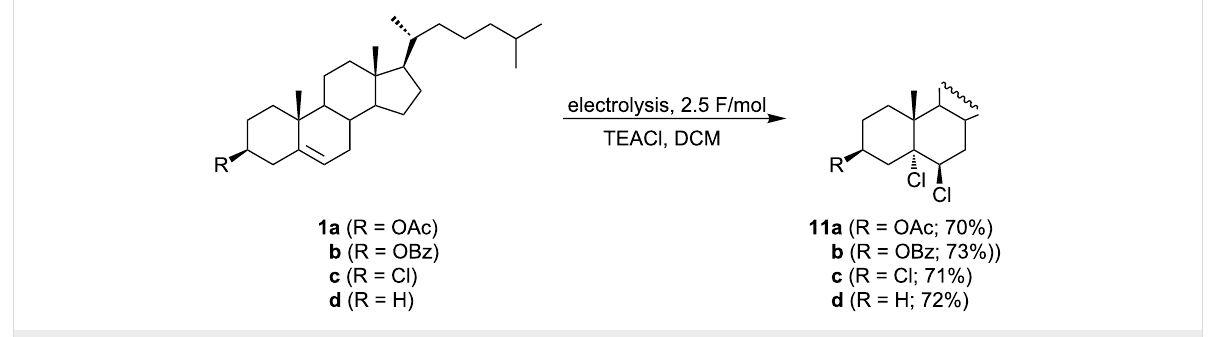
Scheme 5: Electrochemical chlorination of Δ 5 -steroids.